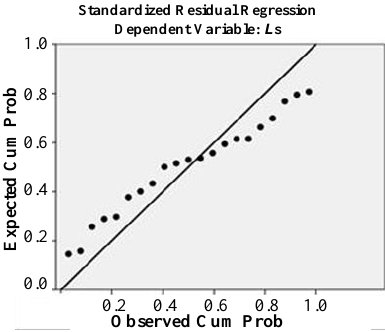
Figure 14. Normal P – P plot between observed cum prob and expected cum prob of L s. Similarly, in order to verify the accuracy of the model, it conducts repeated tests.The